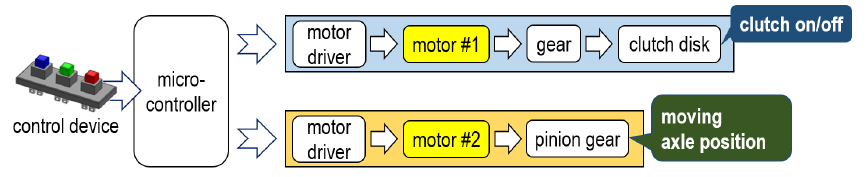
Figure 12. Control schematic of step-ascending wheel